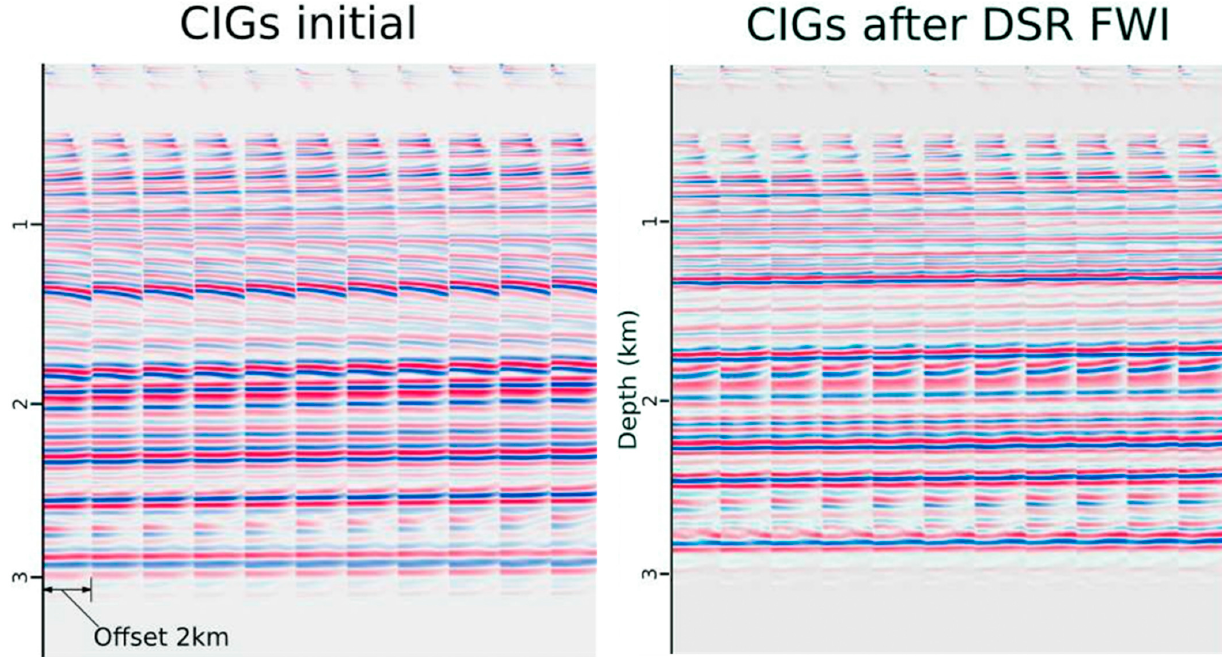
Figure 11. Offset ‐ depth domain Common Image Gathers for 3.5 < x < 3.6 km computed with the initial velocity model (left) and the inverted DSR FWI model (right).